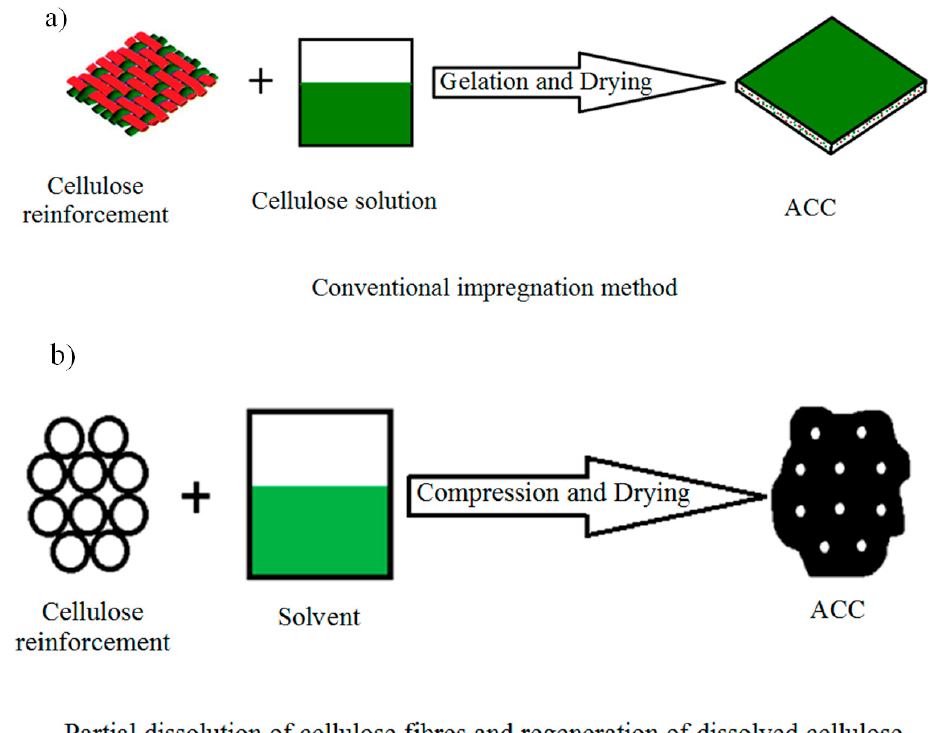
Figure 1. Schematic of processing approaches of all-cellulose composites (ACCs): ( a ) conventional impregnation method (CIM) and ( b ) partial dissolution (PD) method.